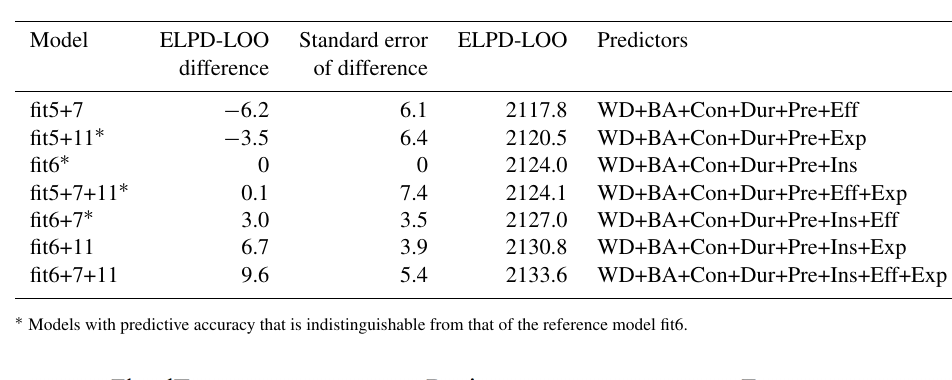
ambiguous in the southern region is that for flood experience (Fig.